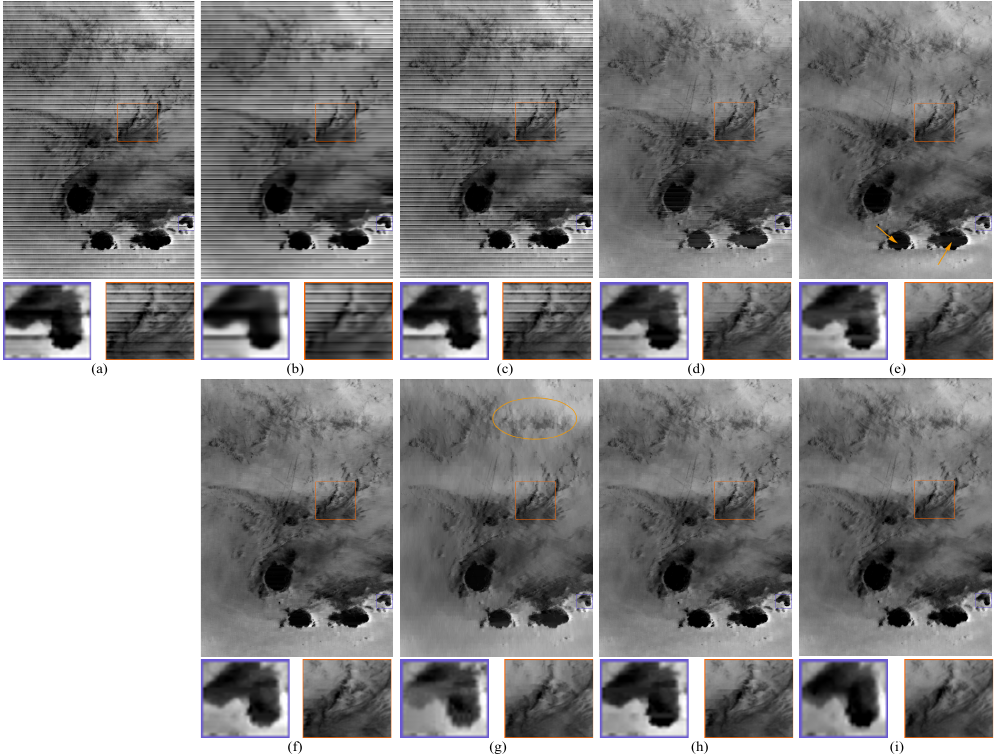
Figure 17. Results of different methods on MODIS data band 27 R1. ( a ) original; ( b ) BM3D; ( c ) SNRCNN; ( d ) GF-based; ( e ) WAFT; ( f ) UV; ( g ) HUTV; ( h ) SUV; ( i ) WDSUV. Zoom in for better visualization.